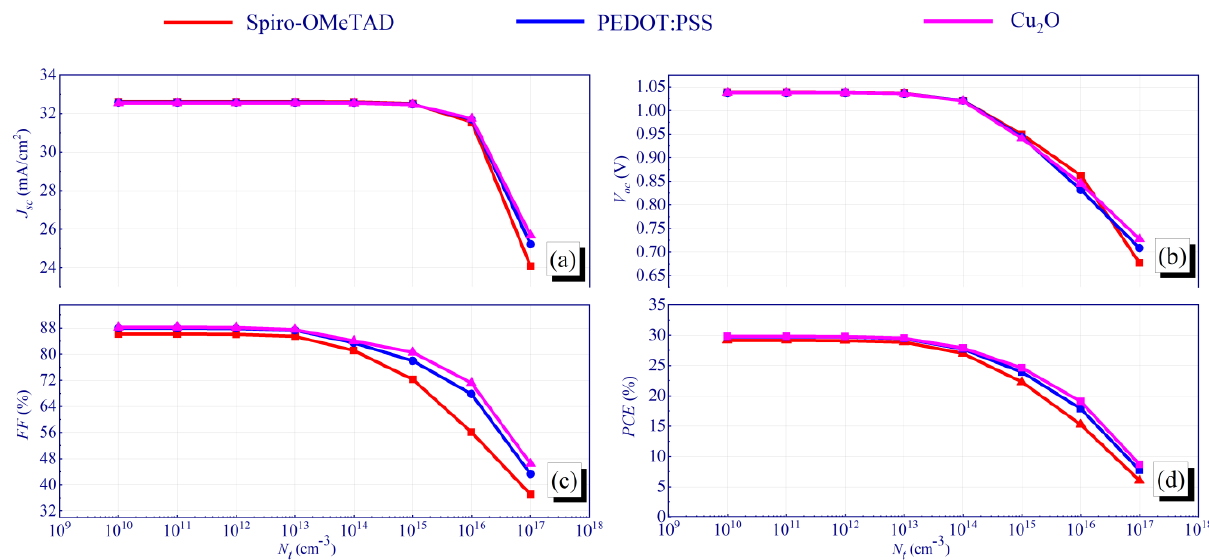
Figure 3. Influence of the bulk defect concentration ( N t ) on the performance parameters of the С H 3 NH 3 SnI 3 -based solar cell with various hole-transporting layers: ( a ) J SC , ( b ) V OC , ( c ) FF , ( d ) PCE